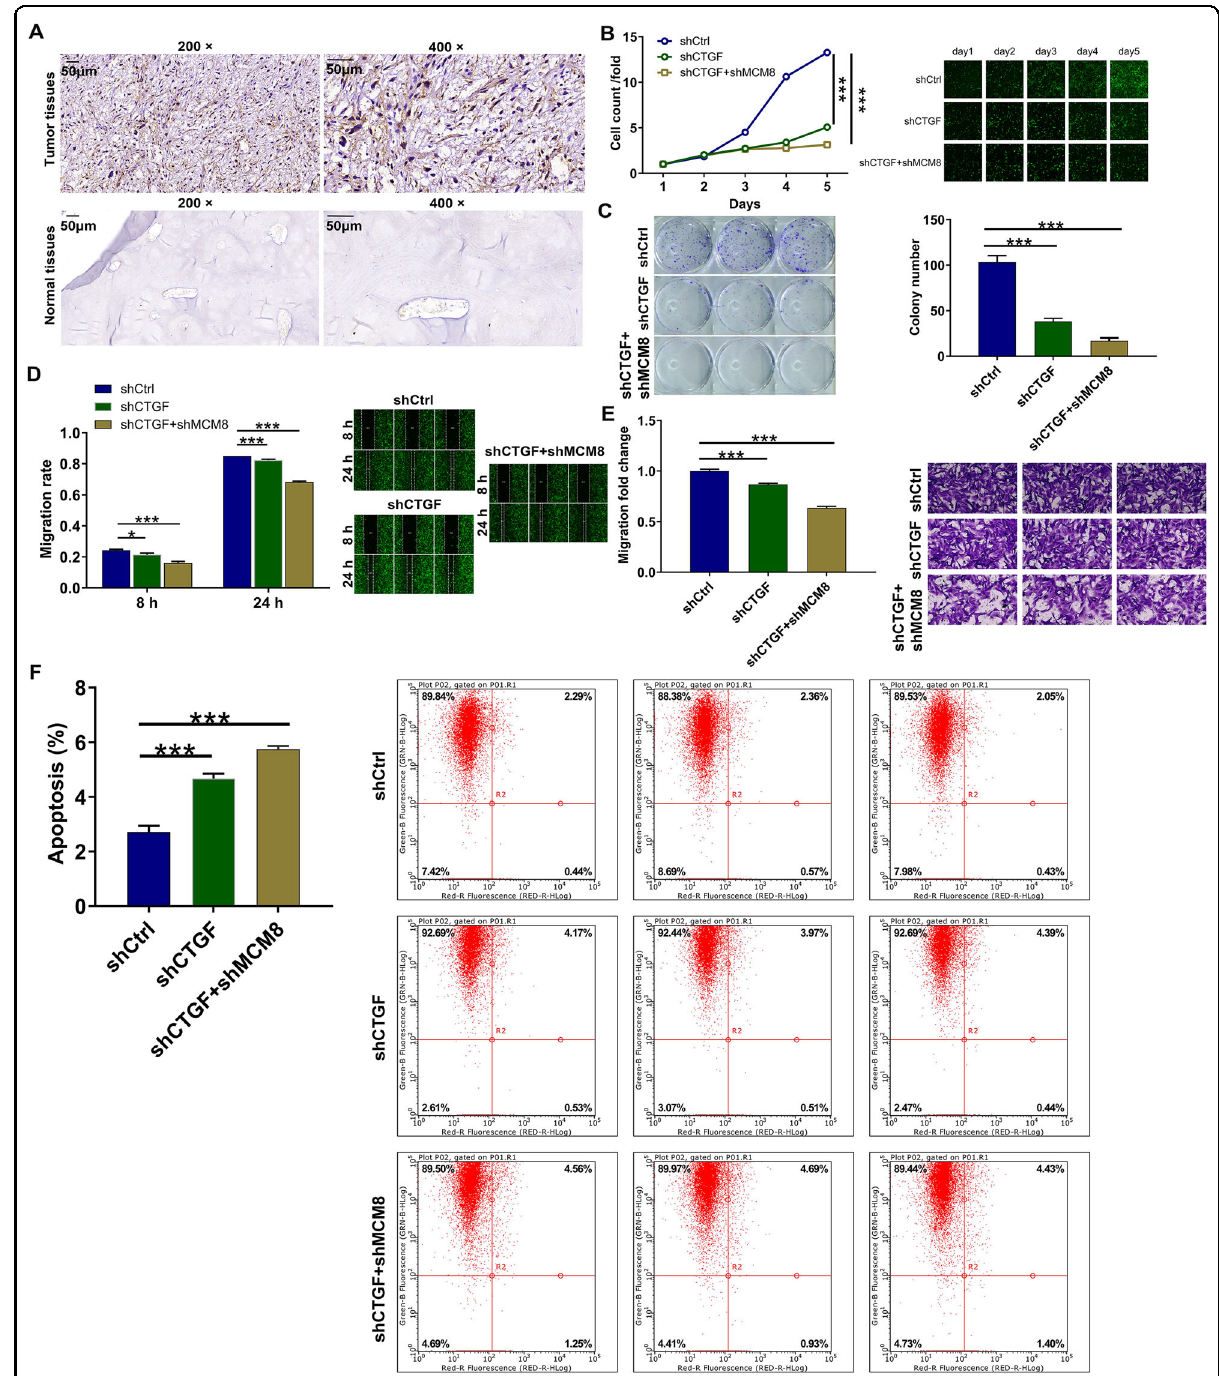
Fig. 5 Knockdown of CTGF strengthened the suppression of osteosarcoma caused by MCM8 knockdown. A The expression of CTGF in tissues of normal and tumor was detected by IHC analysis. B Celigo cell counting assay was employed to show the effects of CTGF knockdown on MNNG/ HOS cell proliferation in shCTGF and shMCM8 + shCTGF groups. C Colony formation assay was used to evaluate the ability of MNNG/HOS cells to form colonies in shCTGF and shMCM8 + shCTGF groups. D The migration rate of cells was detected in shCTGF and shMCM8 + shCTGF groups by wound-healing assay. E The migration rate of cells was detected in shCTGF and shMCM8 + shCTGF groups by transwell assay. Magni fi cation times: ×200. F The cell apoptosis was examined by fl ow cytometry in shCTGF and shMCM8 + shCTGF groups. Results were presented as mean ± SD. * P < 0.05, *** P <